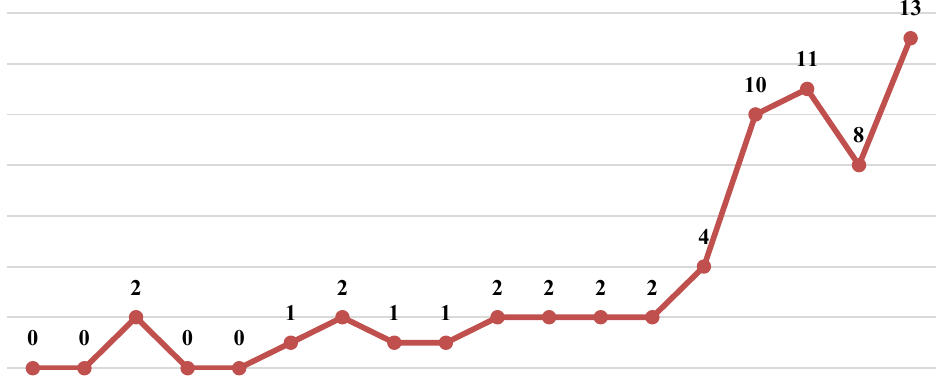
Fig. 1. The dynamics of “resilience” occurrences in the investigated studies, 2000–2022 (up to 7 September) (developed by the authors based on Web of Science data,